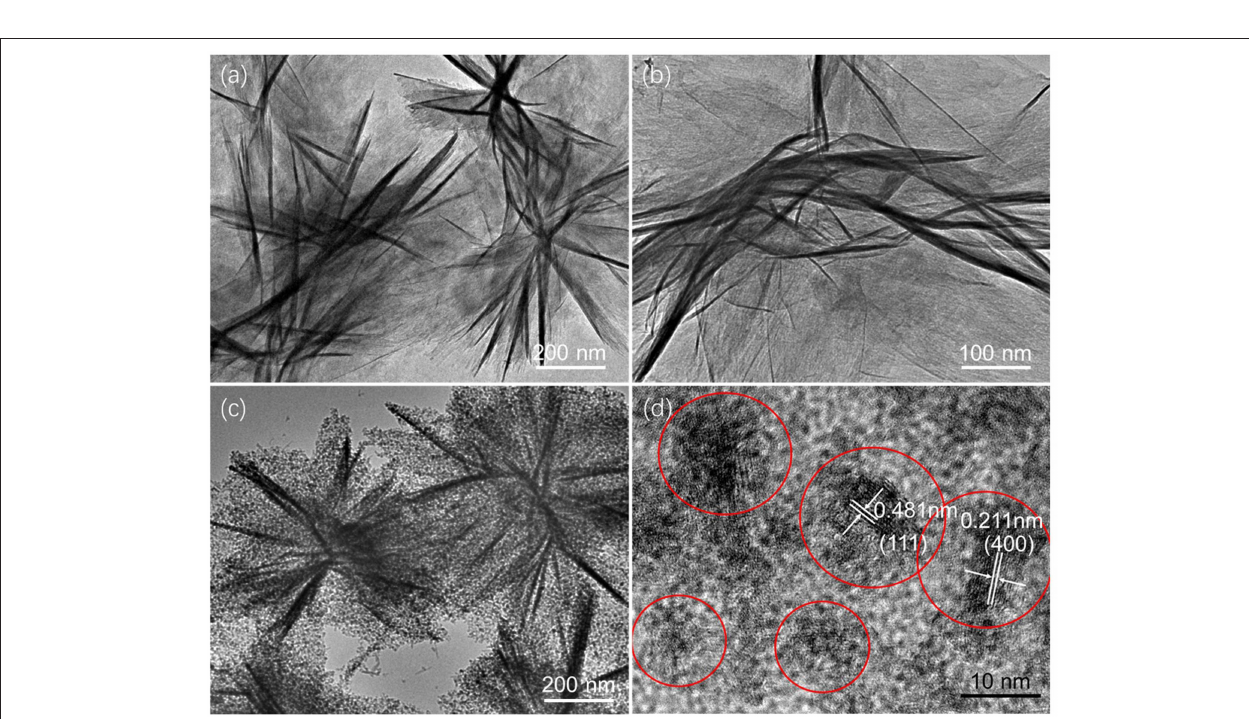
FIGURE 3 | TEM images of the as-prepared (a,b) γ -AlOOH, (c) γ -AlOOH/Fe(OH) 3 micro/nanoflowers, and (d) the HRTEM image of Fe(OH) 3 .